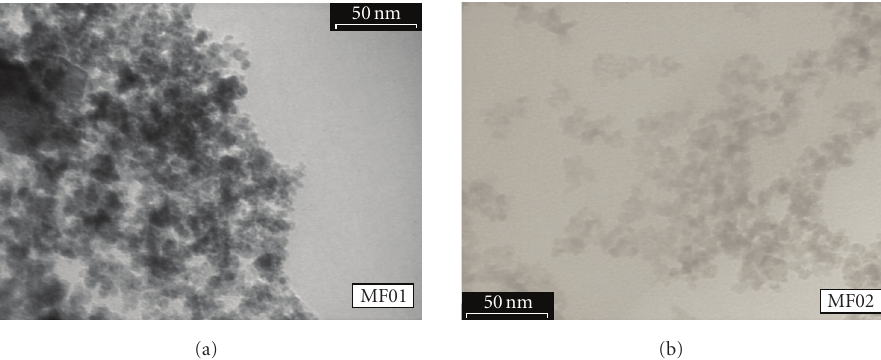
Figure 8: TEM images showing the morphology of the magnetic nanofluids prepared from samples MF01 and MF02, respectively.